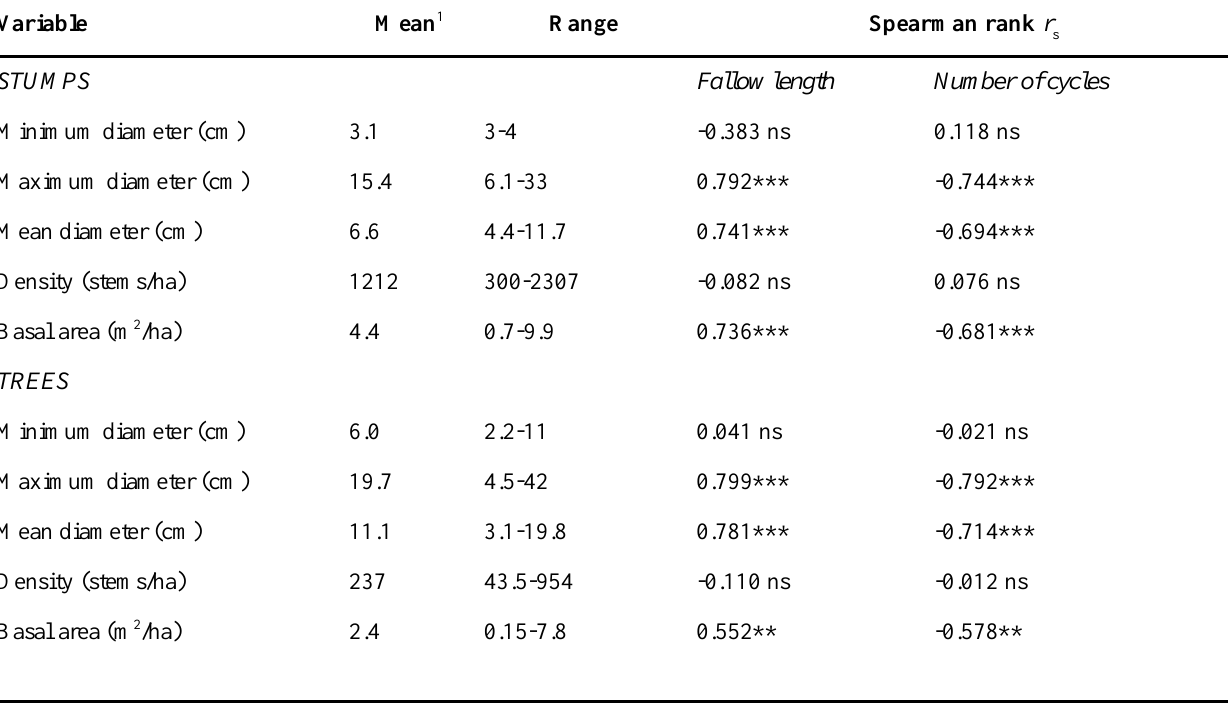
Table 3. Descriptive statistics for diameter, density, and basal area of spared trees and stumps of the preferred firewood species, and Spearman rank correlations of these variables with fallow history, the length of the last fallow period, and the number of